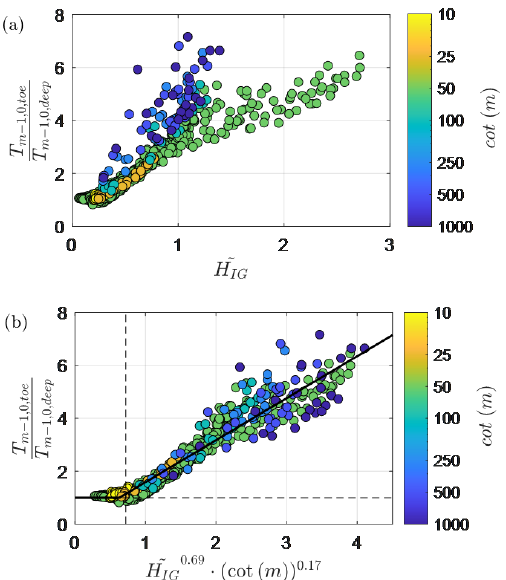
Figure C2. Numerically modelled relative spectral wave period as a function of (a) ˜ H IG alone and (b) ˜ H IG and an additional foreshore slope term. Solid line represents Eq. (C4). Dashed vertical line indi- = 1, and dashed horizontal line represents the cates h toe /H m 0 , deep deep-water limit, where T m − 1 , 0 , toe /T m − 1 , 0 , deep ≈ 1.